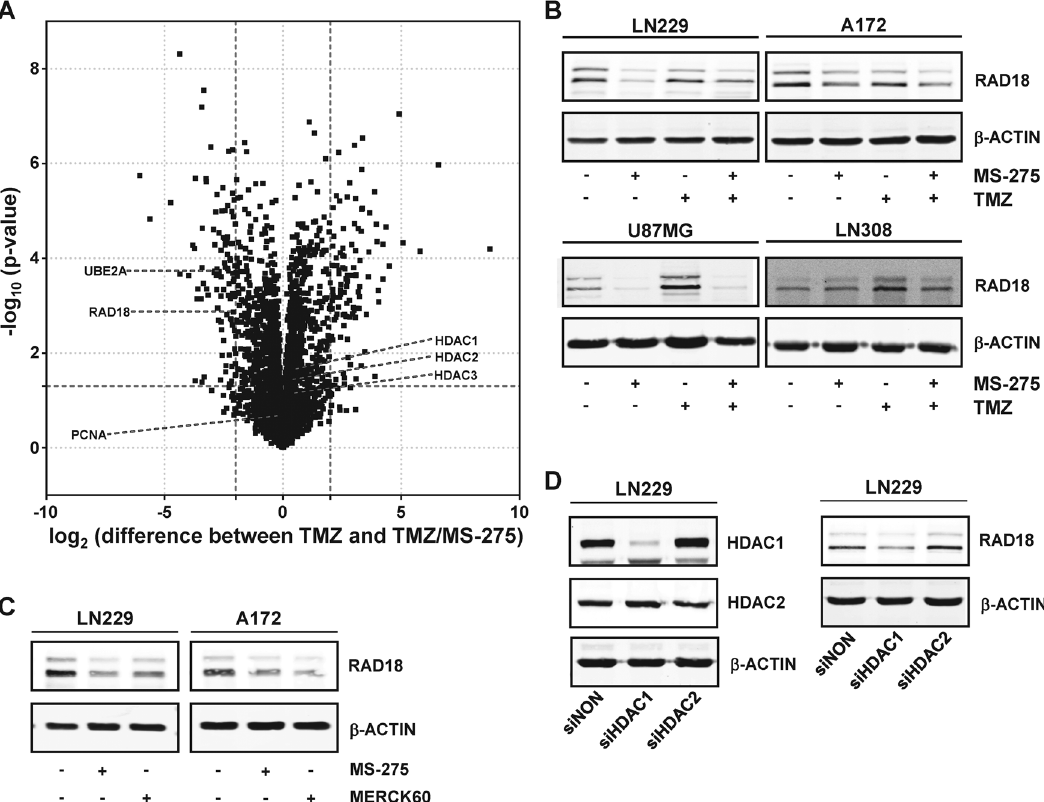
Fig. 3 In fl uence of HDACi on TMZ-induced protein expression. A Volcano Plot of data obtained by quantitative mass spectrometry comparing LN229 cells exposed to TMZ and TMZ/MS-275 for 72 h. Approximately 4000 proteins were detected in quadruple samples, of which 196 were signi fi cantly altered by MS-275. B In fl uence of MS-275 on the expression of RAD18 in glioma cells. The RAD18 protein expression of glioma cells (LN229, A172, U87MG, LN308) upon treatment was determined by Western blotting. Cells were exposed to MS-275 (1.5 µM), TMZ (50 µM) and TMZ/MS-275 and the assay was performed 72 h later. C In fl uence of MERCK60 on the expression of RAD18 in LN229 and A172 cells as determined by western blotting. Cells were exposed to MS-275 (1.5 µM) or MERCK60 (1.5 µM) and the assay was performed 72 h later. D In fl uence of HDAC1 or HDAC2 on the expression of RAD18 in LN229 cells as determined by western blotting. HDAC1 and HDAC2 were knocked down using RNAi and the assay was performed 144 h later. For B , C , and D ß-ACTIN served as loading after treatment using the Sub-G 1 assay. Plasmid information is listed in Table S3. LN229 and A172 cells were transfected with siRNA targeting RAD18 (ON- TARGETplus Human RAD18 siRNA; Dharmacon) and negative control siRNA